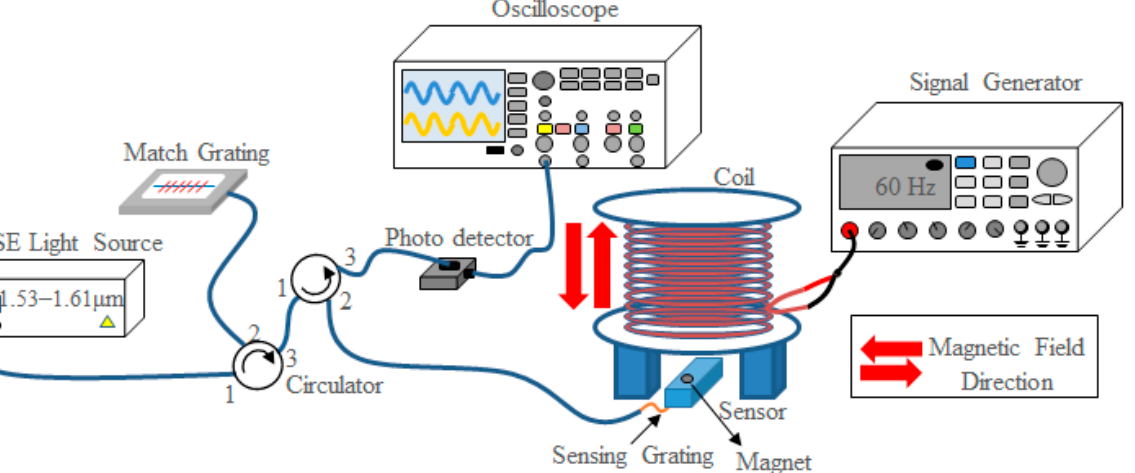
Figure 2. The experimental setup for measuring the low-frequency AC magnetic field. The numbers of the circulators indicate the ports and the direction of light.